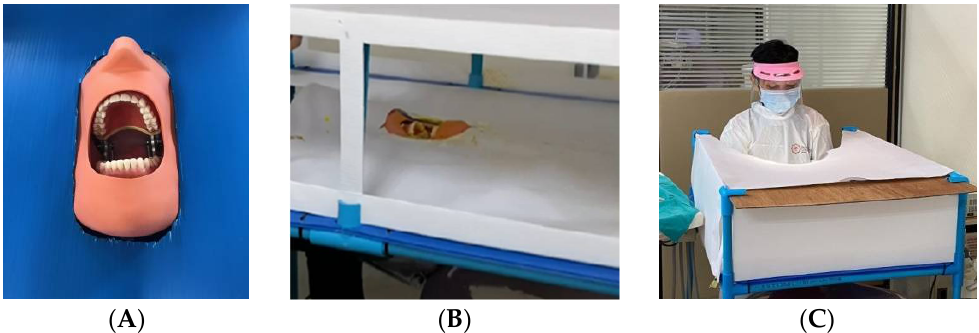
Figure 1. ( A ) A typodont manikin head setting. ( B ) The laboratory platform before it was covered by papers. ( C ) The operator worked in the laboratory platform set-up